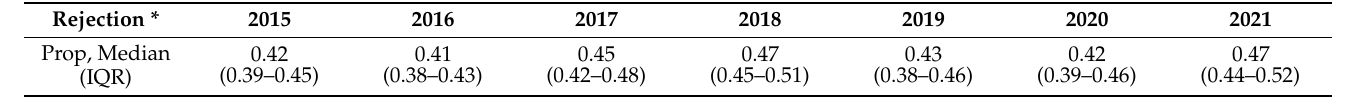
Table 5. Total rejection episodes corrected for number of transplants performed per year in Brazil’s Unified Healthcare System